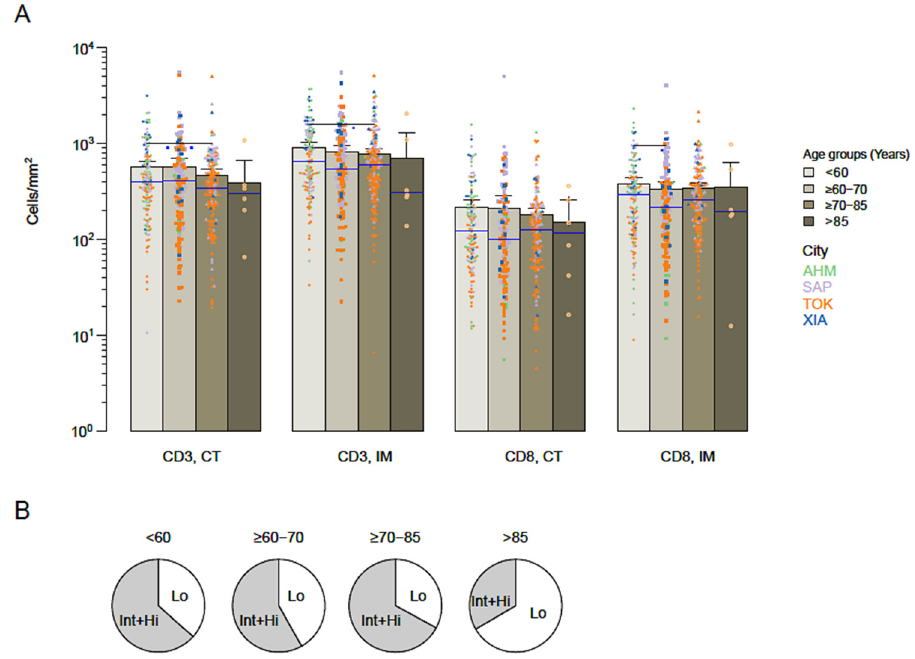
Figure 1. The immune infiltrate and Immunoscore in patients based on age. ( A ) Patients were grouped according to their age: <60 years (orange), ≥ 60–70 (yellow), ≥ 70–85 (purple), and ≥ 85 (blue). Immune densities of CD3 and CD8 quantified in the tumor core (CT) and invasive margin (IM). Each dot represents the mean whole-slide quantification for one patient. ( B ) Distribution of Intermediate and High (Int+Hi) versus Low (Lo) Immunoscore in age-based patient groups. AHM (Ahmedabad, India); SAP (Sapporo, Japan); TOK (Tokyo, Japan); XIA (Xi’an, China).